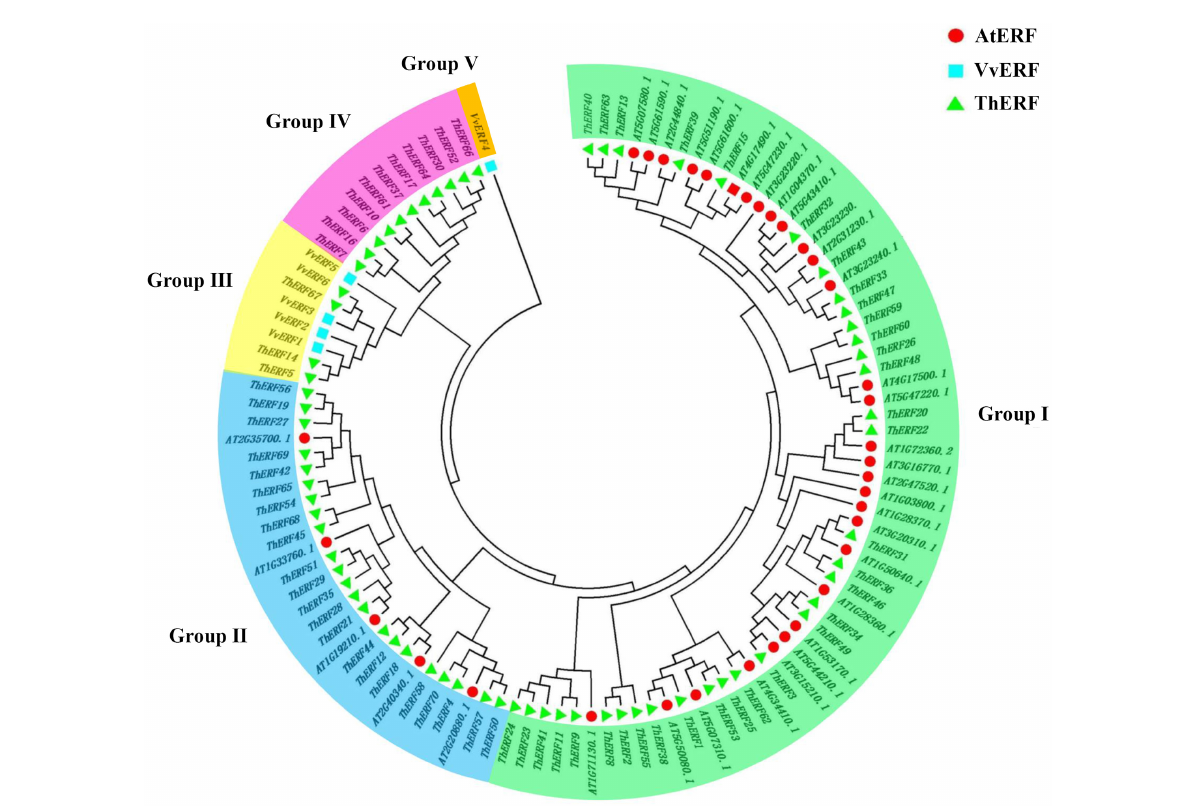
FIGURE2 Phylogenetic tree of AP2/ERF transcription factors in T. hemsleyanum . Deduced full-length amino acid sequences were used to construct the phylogenetic tree with the MEGA 7.0 software using a neighbor-joining method with 1,000 bootstrap replicates. Five groups are highlighted in different